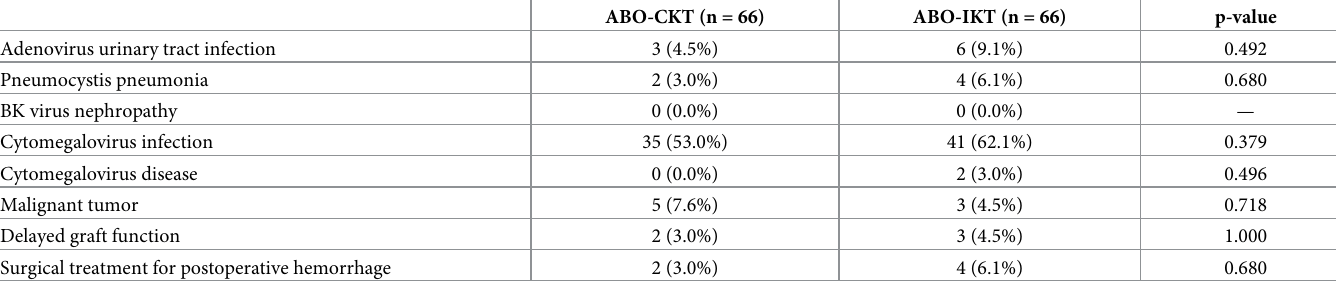
Table 4. Comparison of complications between ABO-CKT and ABO-IKT after propensity score